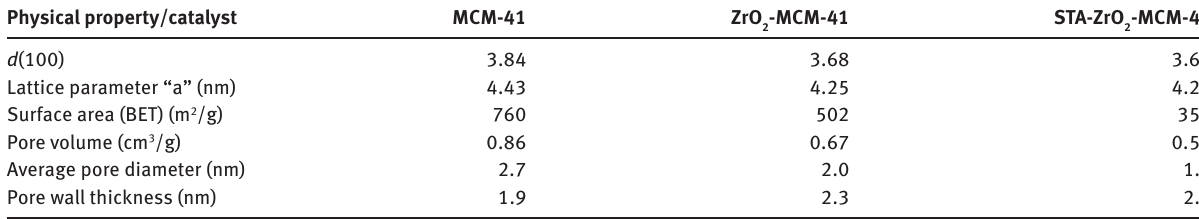
Table 1: Physical properties of the MCM-41 supported catalysts. Physical property/catalyst